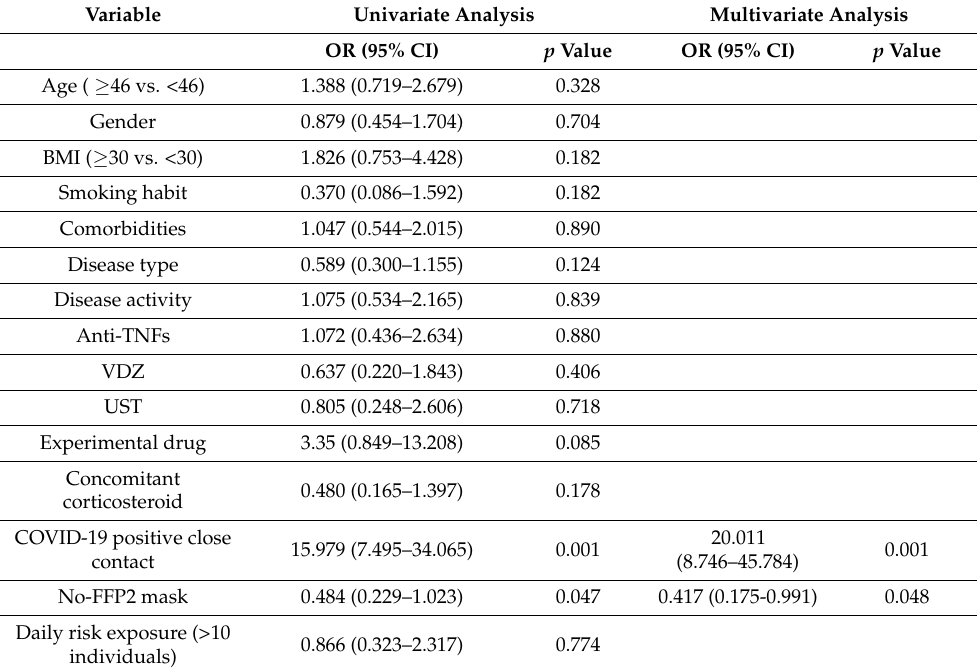
Table 3. Univariate and multivariate analyses of variables associated with a positive antibody sero- prevalence.